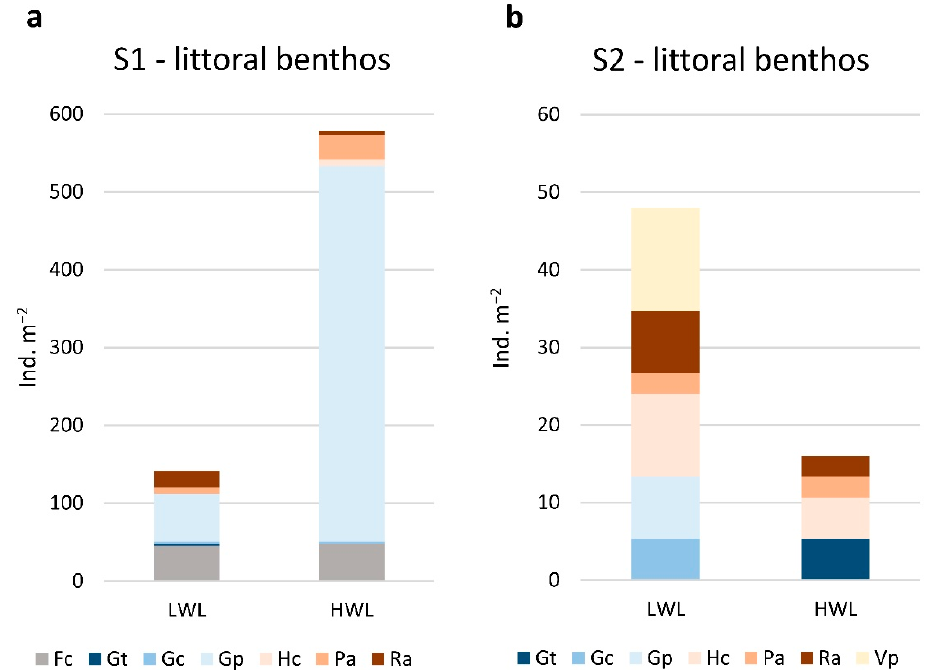
Figure 4. Gastropod abundance in the littoral benthal area of S1 ( a ) and S2 ( b ). Abbreviations of species names are given in Materials and Methods.